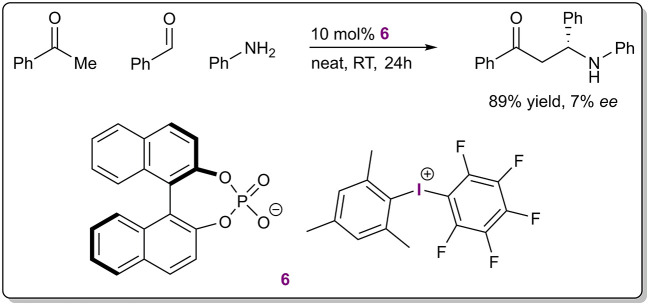
Three-component Mannich reaction catalyzed by diaryliodonium salt 6.